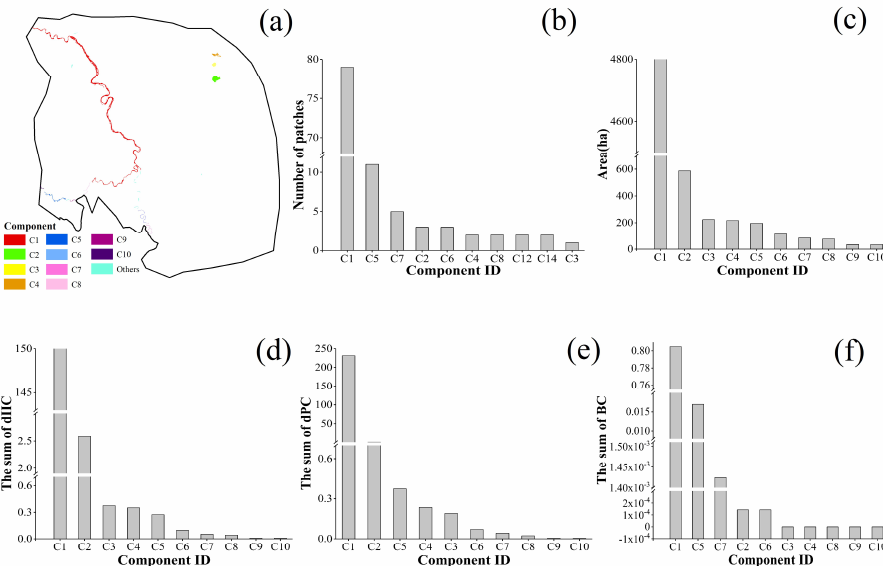
Figure A2. Statistics of different indices for the top 10 components in terms of connectivity for 2010. ( a ) Distribution of components, ( b ) Number of patches (n), ( c ) Area of components (ha), ( d ) The sum of dIIC, ( e ) The sum of dPC, and ( f ) The sum of BC. C1 = Yellow River floodplain, C2 =